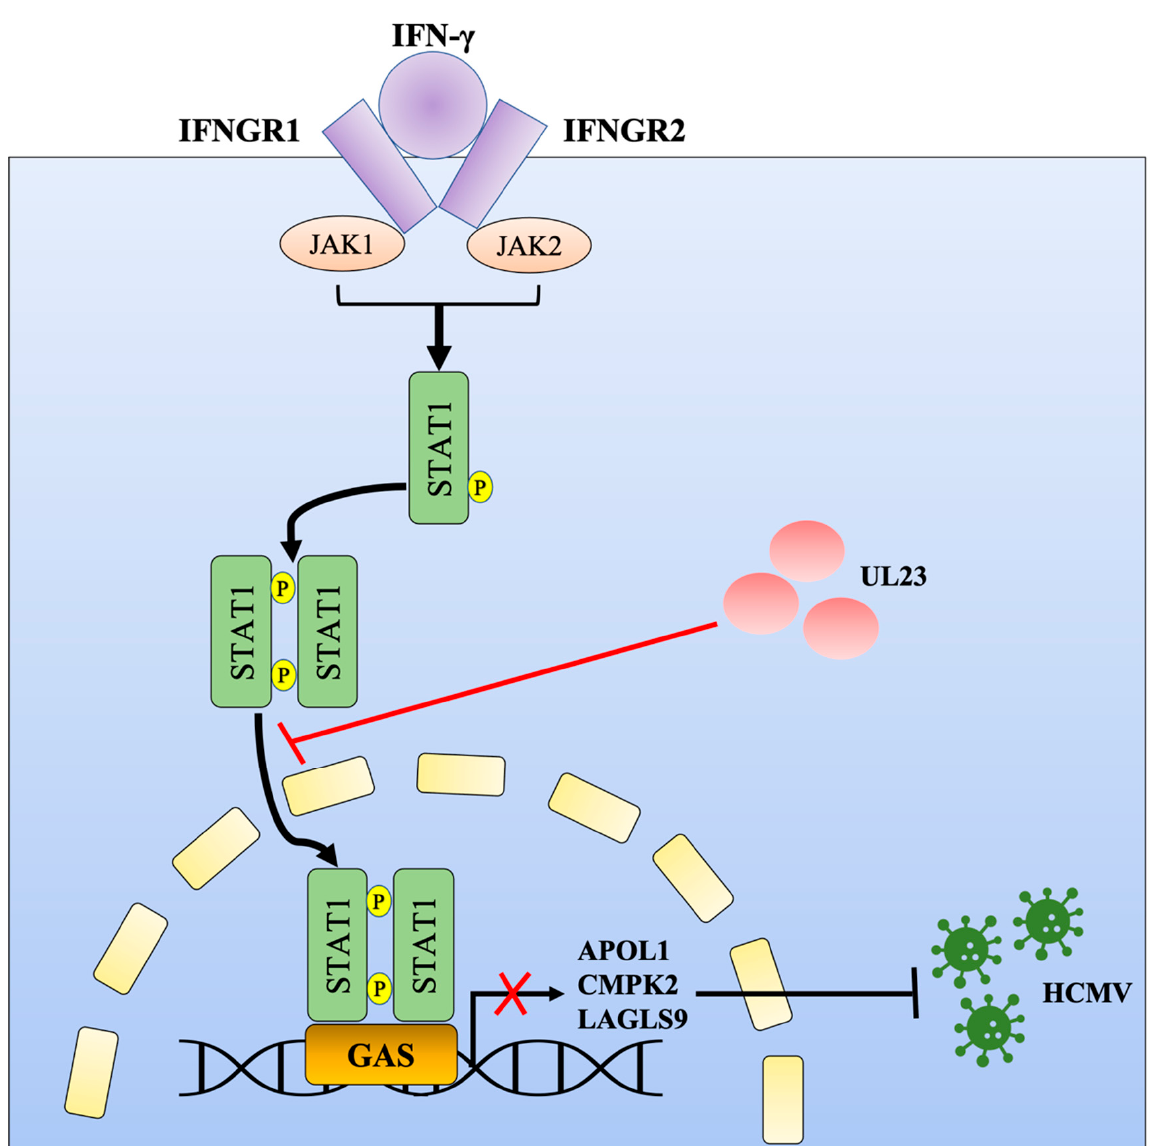
Figure 5. A model for the HCMV UL23-mediated suppression of IFN - γ -mediated ISG transcription (APOL1, CMPK2, and LGALS9). During HCMV infection, UL23 disrupts the phosphorylation and nuclear localization of STAT1 and reduces ISG transcription and GAS promoter activation; in the meanwhile, it restrains the inhibitory e ff ects of APOL1, CMPK2, and LGALS9 on HCMV replication. Supplementary Materials: The following supporting information can be downloaded at: www.mdpi.com/xxx/s1, Figure S1: KEGG pathway enrichment and GO analysis of the di ff erential genes regulated by UL23; Figure S2: The e ff ect of APOL1, CMPK2, and LGALS9 on HCMV entry into cells .